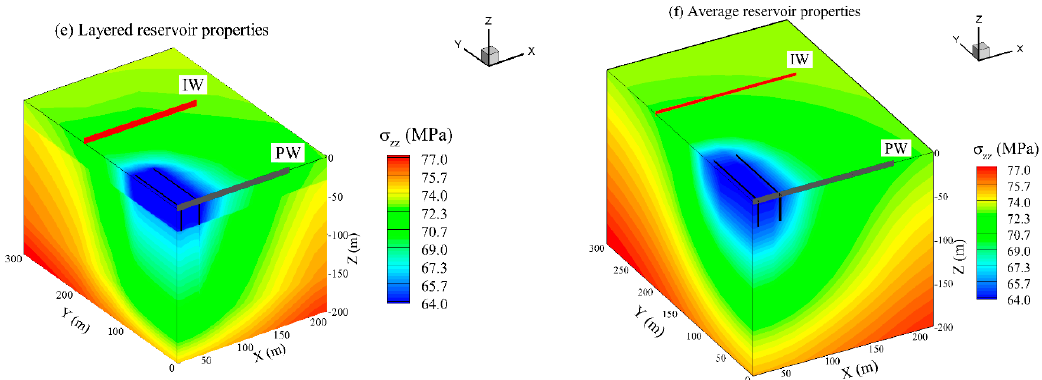
Figure 9. A comparison of reservoir stresses distribution from the FEM model (with layered reservoir properties) and the DD model (with average reservoir properties) after 2 years of production: ( a , b ) the minimum horizontal stress, ( c , d ) the maximum horizontal stress, and ( e , f ) the vertical stress.